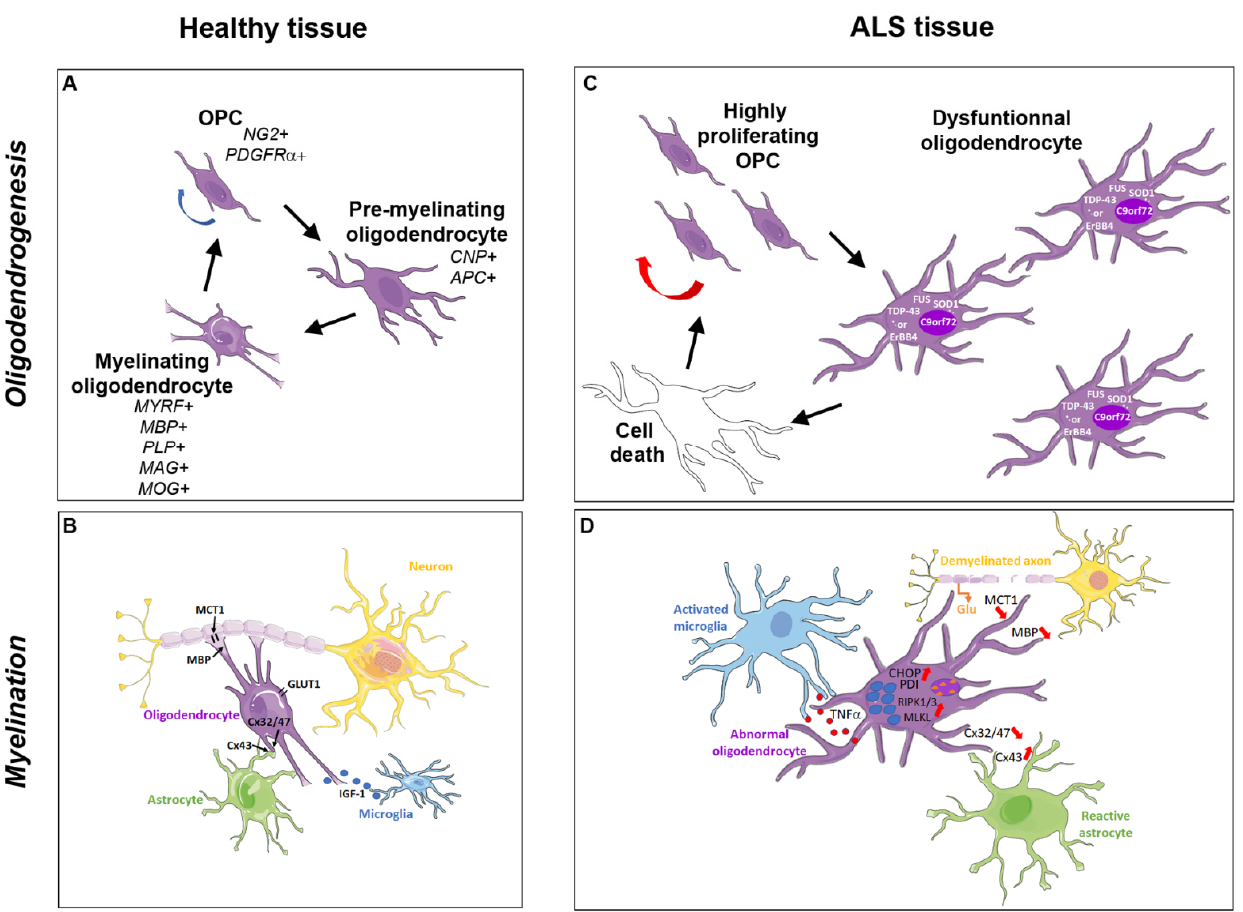
Figure 1. Pathological oligodendrogenesis and myelination in amyotrophic lateral sclerosis (ALS) disease. ( A ) In the healthy central nervous system (CNS), oligodendrogenesis comprises the differentiation of oligodendrocyte progenitor cells (OPC) into pre-myelinating oligodendrocytes, which mature into myelinating cells. Specific markers of each phenotypic step are indicated. The blue arrow indicates the proliferation of OPCs. ( B ) Myelination of neuronal axons by oligodendrocytes takes place in the presence of microglial and astroglial cells, which are known to participate namely in the differentiation of OPCs (via the secretion of IGF-1) and the supply of metabolic nutrients (via gap junctions enriched in channel forming proteins connexin, Cx) and lipids for myelin sheath production. ( C ) During ALS disease, oligodendrogenesis is characterized by the increase of OPC proliferation, which gives rise to a higher number of differentiated oligodendrocytes. The latter are dysmorphic and display various protein aggregates in their cytoplasm including (TDP-43 or ErBB4, SOD1, FUS) or accumulate abnormal dipeptide repeat proteins (C9orf72) in their nucleus. These abnormal oligodendrocytes are unable to mature into myelinating cells and ultimately die. In response to cell death, OPC proliferation is highly increased (red arrow). ( D ) Cellular and molecular mechanisms involved in ALS pathology include axon demyelination and degeneration that may occur as the primary or secondary event compared to the death of oligodendrocytes. Both glutamate excitotoxicity (orange broken arrow) from the degenerating neurons and the dysregulation of protein folding leading to abnormal aggregates (blue and orange ellipses) lead to endoplasmic reticulum stress resulting into the increase of the ER stress apoptotic mediator CHOP and into the activation of the unfolded protein response (UPR) associated with the specific expression of select UPR target genes, such as PDI (protein disulfide isomerase). At the level of oligodendrocyte processes, the most abundant myelin protein MBP and the monocarboxylate transporter 1 (MCT1) required for lactate release to the axon are both decreased. The altered communication between the oligodendrocyte and the neighboring astrocytes (green) related to changes in connexin (Cx) expression as well as the pro-inflammatory microglia (blue) namely secreting the cytokine TNF α and triggering the RIPK1/RIPK3/MLKL signaling pathway, both participate in oligodendrocyte dysfunction and degeneration,